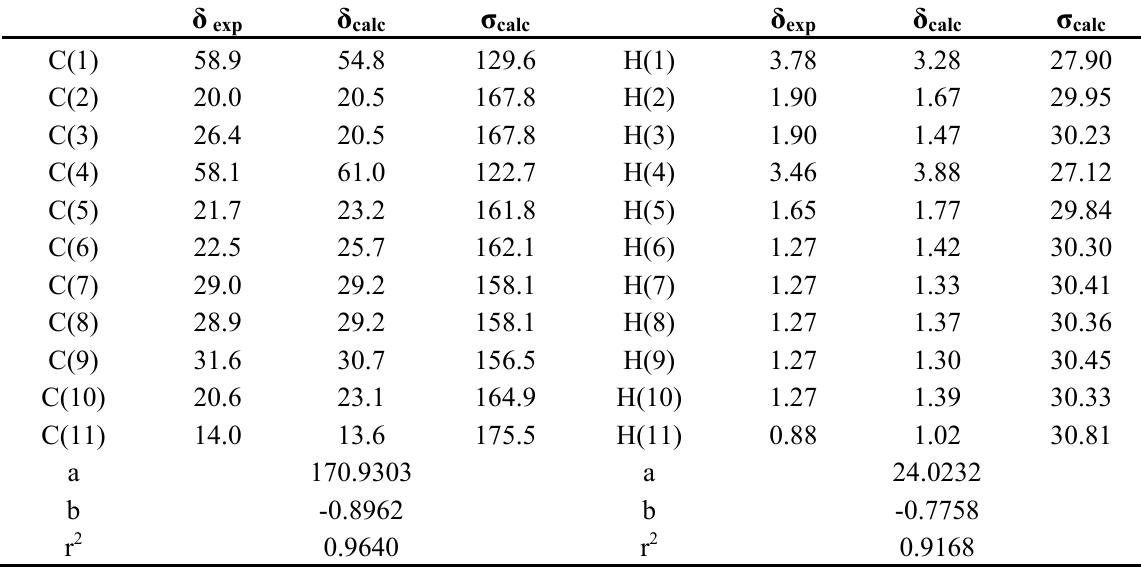
and calculated GIAO nuclear magnetic 3 = a + b· σ with a and b determined exp calc